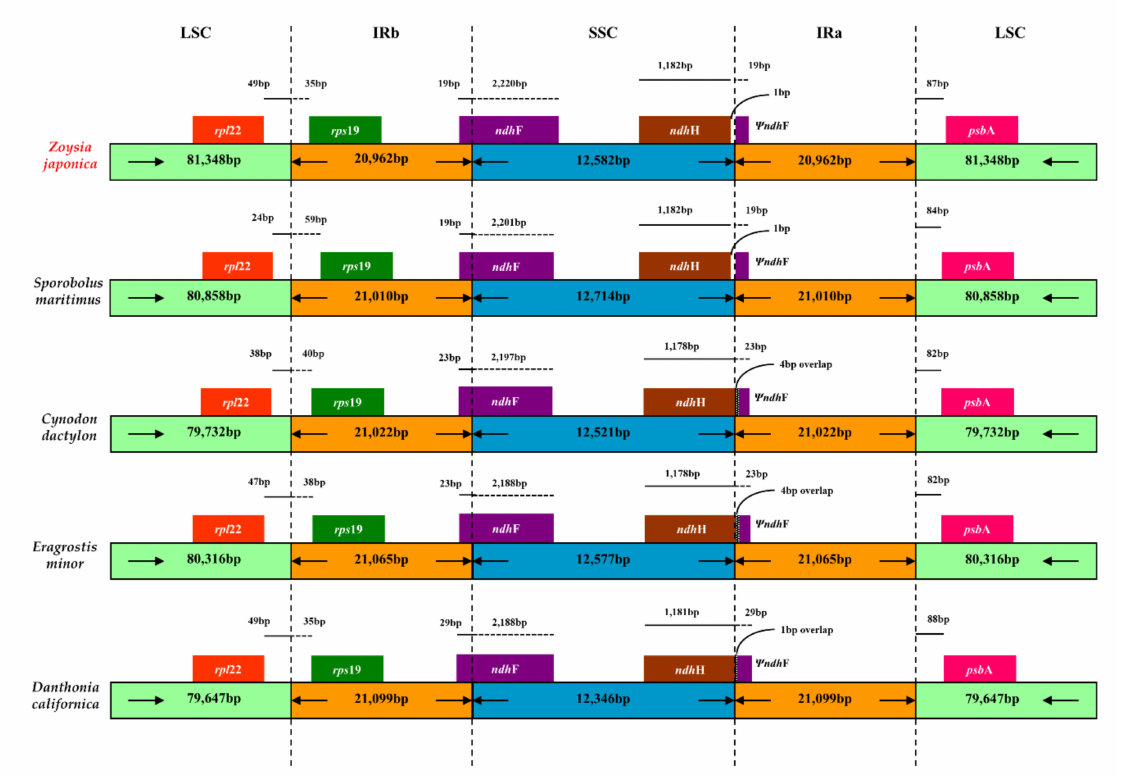
Figure 2. Comparison of the borders of the large single-copy (LSC), small single-copy (SSC), and inverted repeat (IR) regions among the plastomes of five Poaceae species. The IR regions of Zoysia species extend into the ndhF gene, which is characteristic of the PACMAD clade of Poaceae. Four comparative species were selected from closely related genera to Zoysia